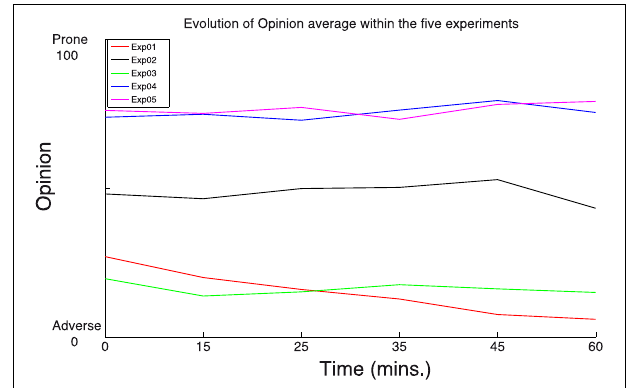
FIGURE 1 | Time evolution of the average opinion within the 5 small group experiments. On the X axis are reported the time steps in which the opinions were collected (i.e., Op In , Op 15 ′ , Op 25 ′ , Op 35 ′ , Op 45 ′ , OpFi ), while on the Y axis is reported the average opinion for each experiment, from adverse (0) to prone (100). In order to facilitate the lecture of the slope and the trend of the trajectories, in the Y axis we took as extremes values 25 for the adverse and 75 for the prone. The colored lines indicate the different experimental sessions.